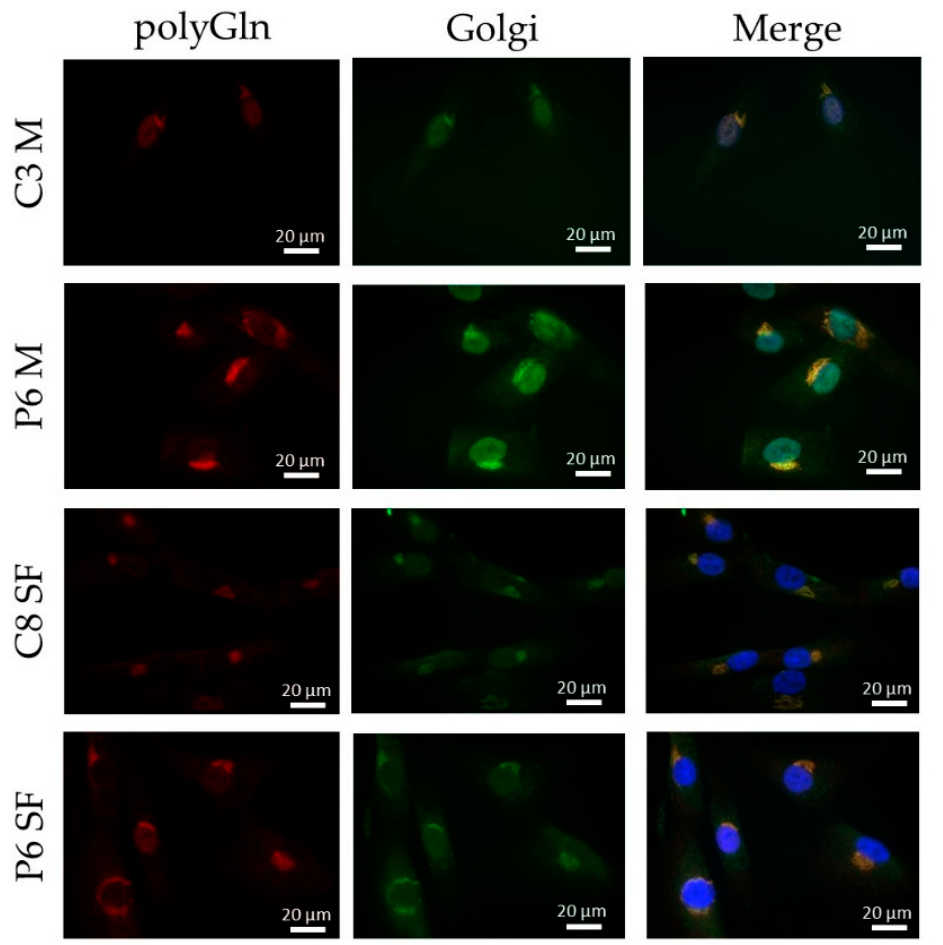
Figure 5. Determination of the origin of the polyGln containing proteins found via the immunofluorescence. Immunofluorescence showing co-localization of the polyGln aggregate found in myoblasts and skin fibroblasts with the commercial antibodies (1C2, alexa fluor-594, red) with the Golgi apparatus (TGN-38, alexa fluor-488 in green). Nuclei stained with DAPI (blue). Abbreviations: C = control; P = DM1 patient; M = myoblasts; SF = skin fibroblasts; polyGln = polyglutamine; Golgi = Golgi apparatus.